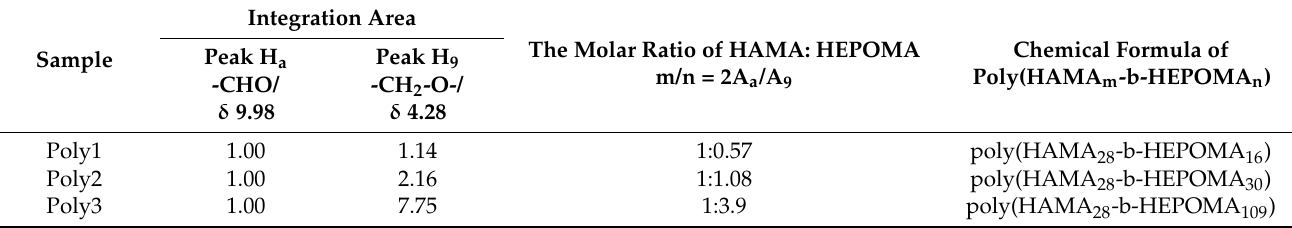
Table 2. The block ratios of poly(HAMA m -b-HEPOMA n ) calculated by 1 H NMR.